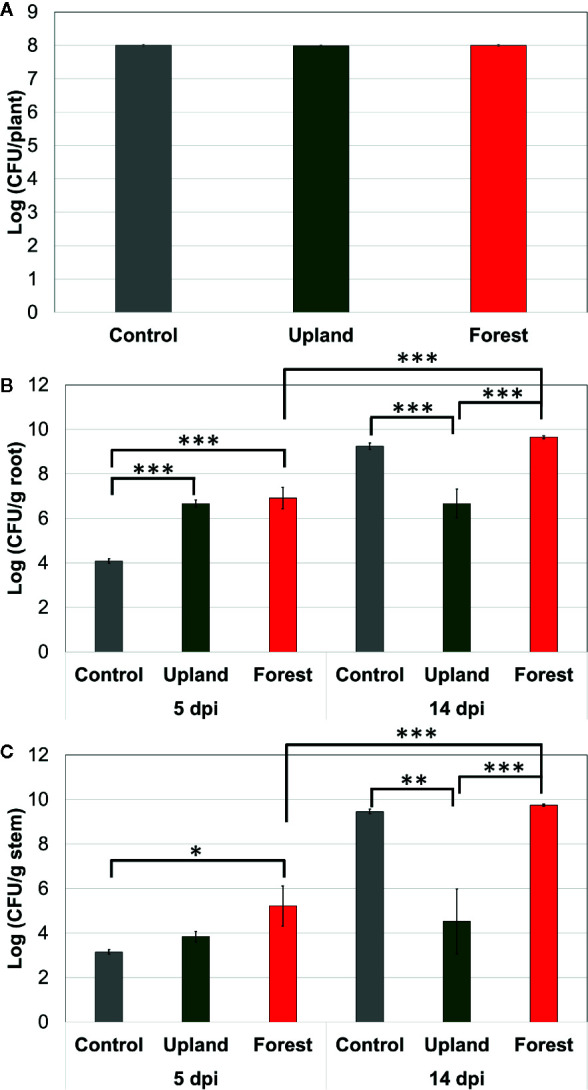
Population dynamics of R. solanacearum SL341 in the tomato rhizosphere (A), roots (B), stems (C) of resistant cultivar treated by upland soil MF and forest soil MF over time. Control was treated with 2.5 mM MES buffer (pH 5.7). Each vertical bar represents the standard error of the mean from three replicates (each replicate with three plants, n = 3) (*p < 0.05; **p < 0.01; ***p < 0.001).